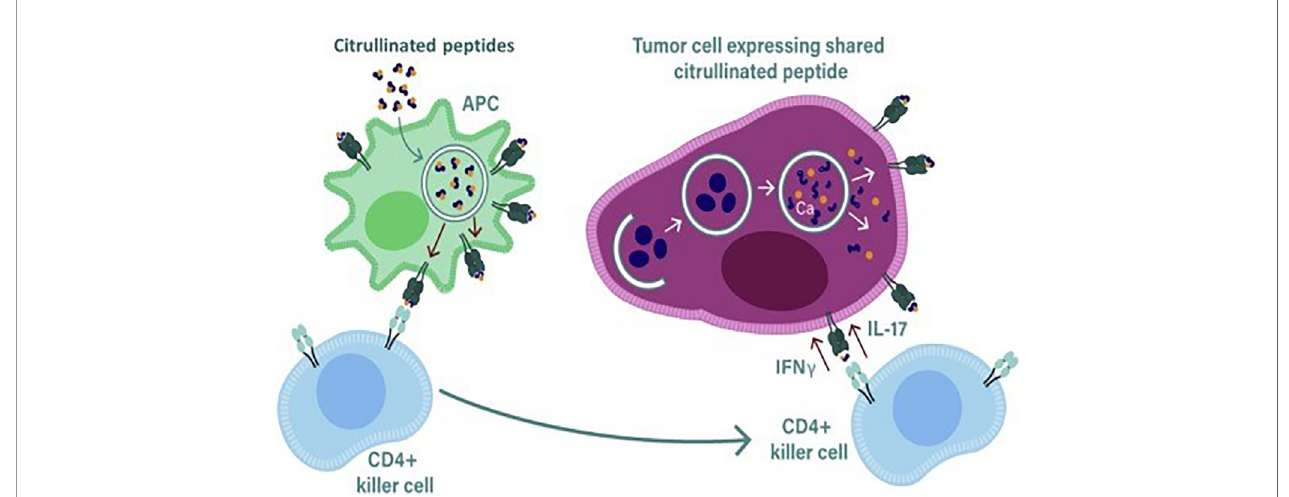
FIGURE 2 | During stress induced autophagy and in the presence of in fl ammation citrullinated peptides can be presented on major histocompatibility complex (MHC) class II molecules for recognition by CD4+ T cells. During in fl ammation many cytokines are produced, the majority are proin fl ammatory that result in the upregulation of MHC class II expression that then activates CD4+ T cells. Primed killer CD4 T cells enter the tumor and are reactivated by APCs presenting citrullinated peptides from tumors allowing recognition and lysis by the killer CD4 T